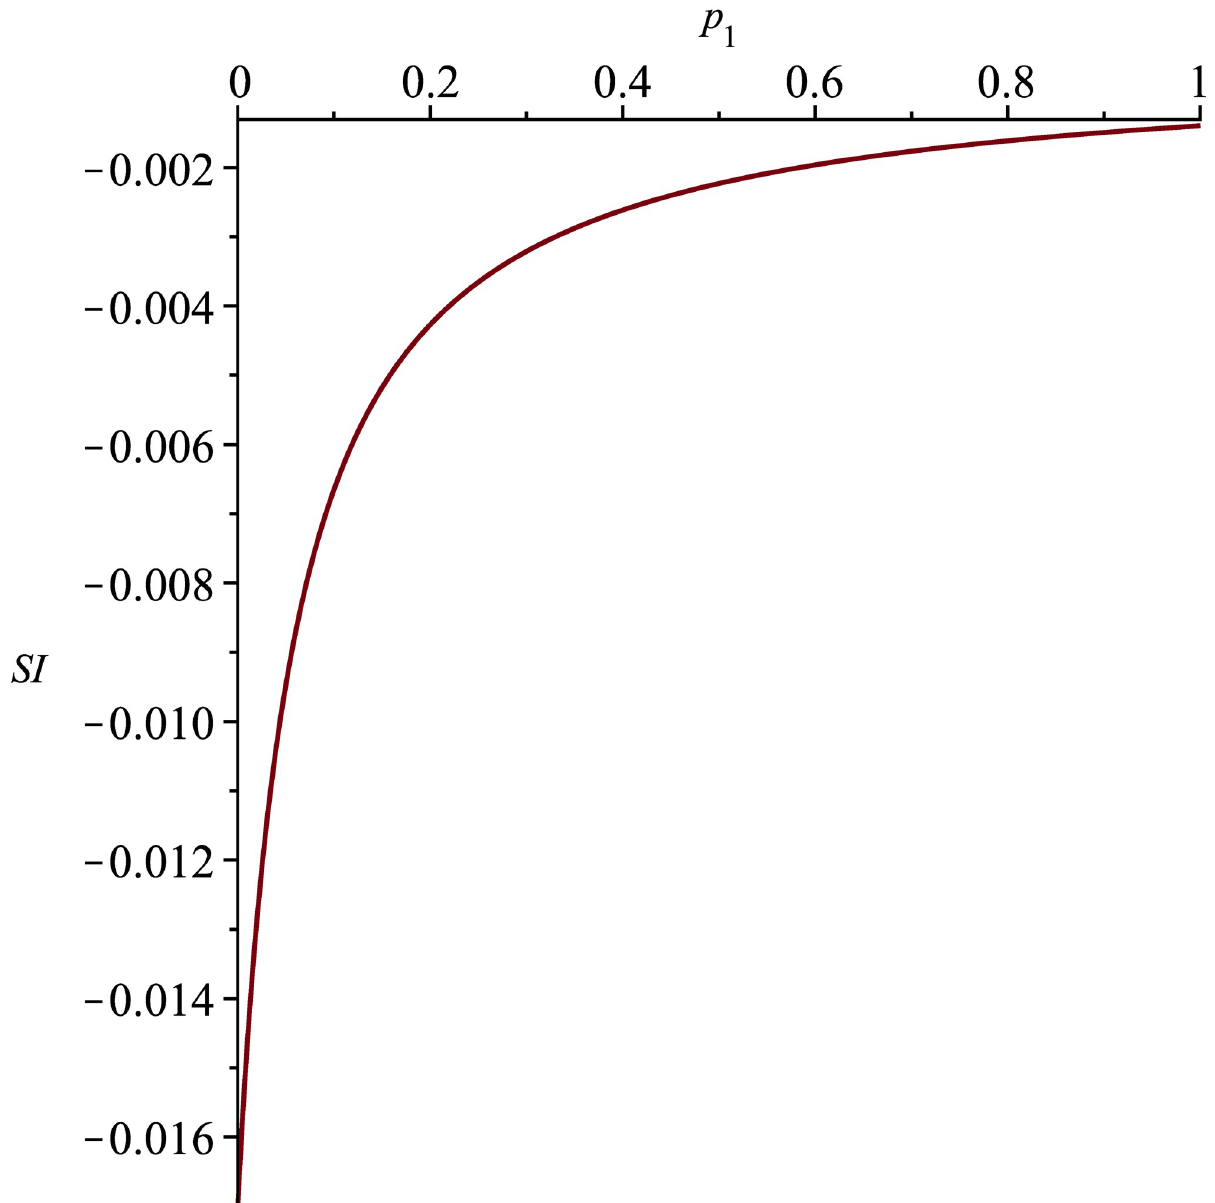
Fig 4. Sensitivity index Ω R 0